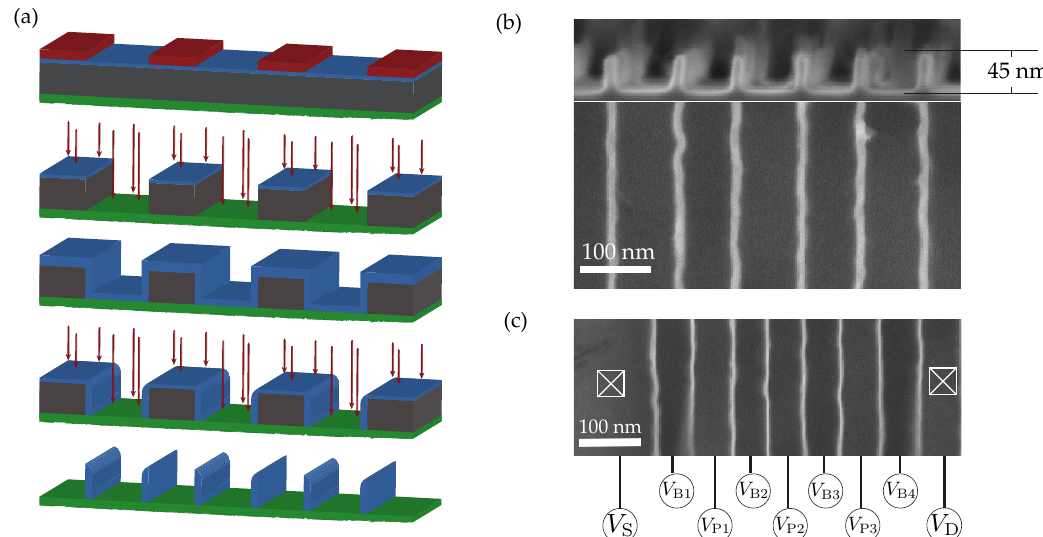
Figure 5. Fabrication steps of the self-aligned spacer process as the basis of a high-density gate structure. ( a ) Schematic of the self-aligned spacer process. Top to bottom: structured resist (red) on the layer-stack including the SiO 2 hard mask (blue), the α Si sacrificial layer (dark grey), and the Al 2 O 3 etch stop layer (green); anisotropic dry-etching; conformal SiO 2 deposition; anisotropic dry back-etching; free-standing oxide spacer. ( b ) Cross-section and top-view scanning electron micrograph of the free-standing SiO 2 spacer with a width of 15nm on a (75 5) nm pitch. The spacer height is 45nm. ( c ) Scanning electron ± micrograph of top-viewed 10 nm free-standing SiO 2 spacer with a 50 nm pitch. Metallic gates between the spacers are not shown here, but voltage labels are added for clarity (cf. Figure 1). The final gate structure is used for top-ridge localization. Ohmic contacts to the electron reservoirs at the ends of the silicon nano-ridge are indicated by crossed